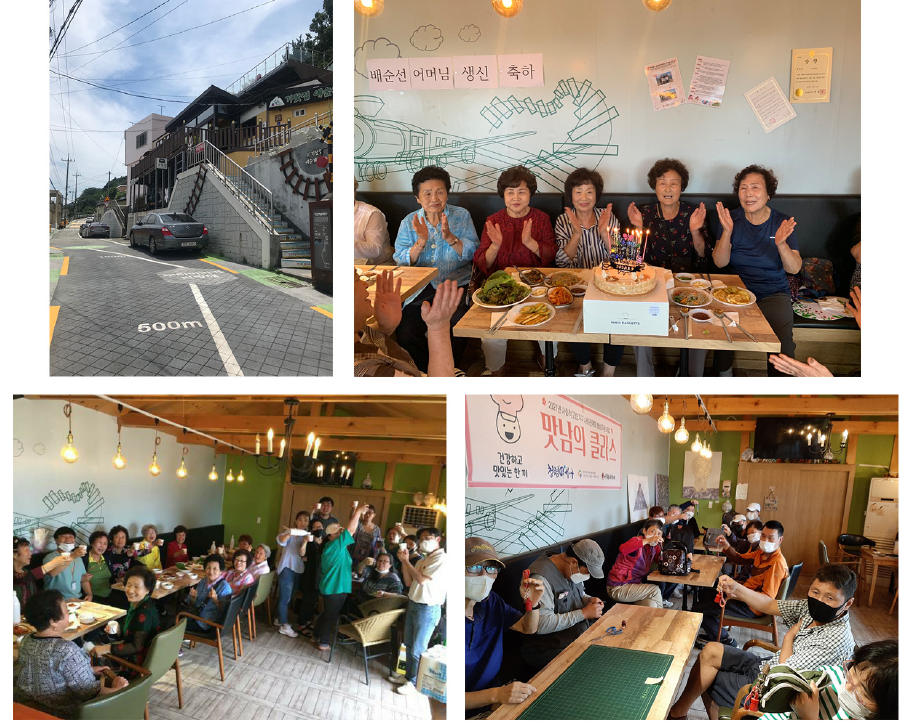
Figure 3. Railroad House Art Experience Center and programs organized by Ami-Moms.